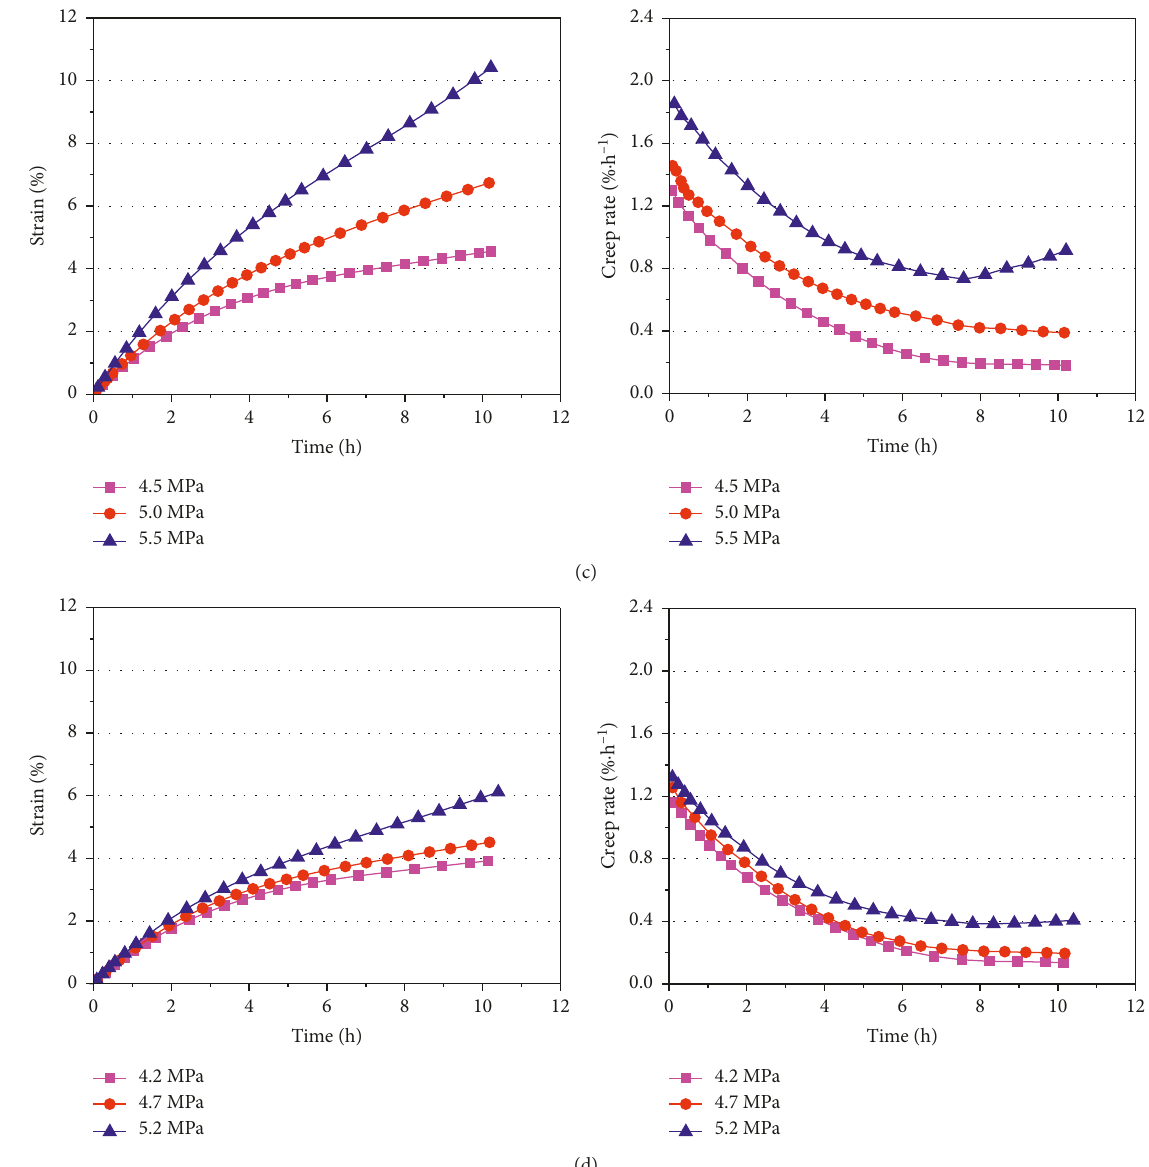
Figure 4: Variations in the axial creep strain and axial creep rate with time ( σ